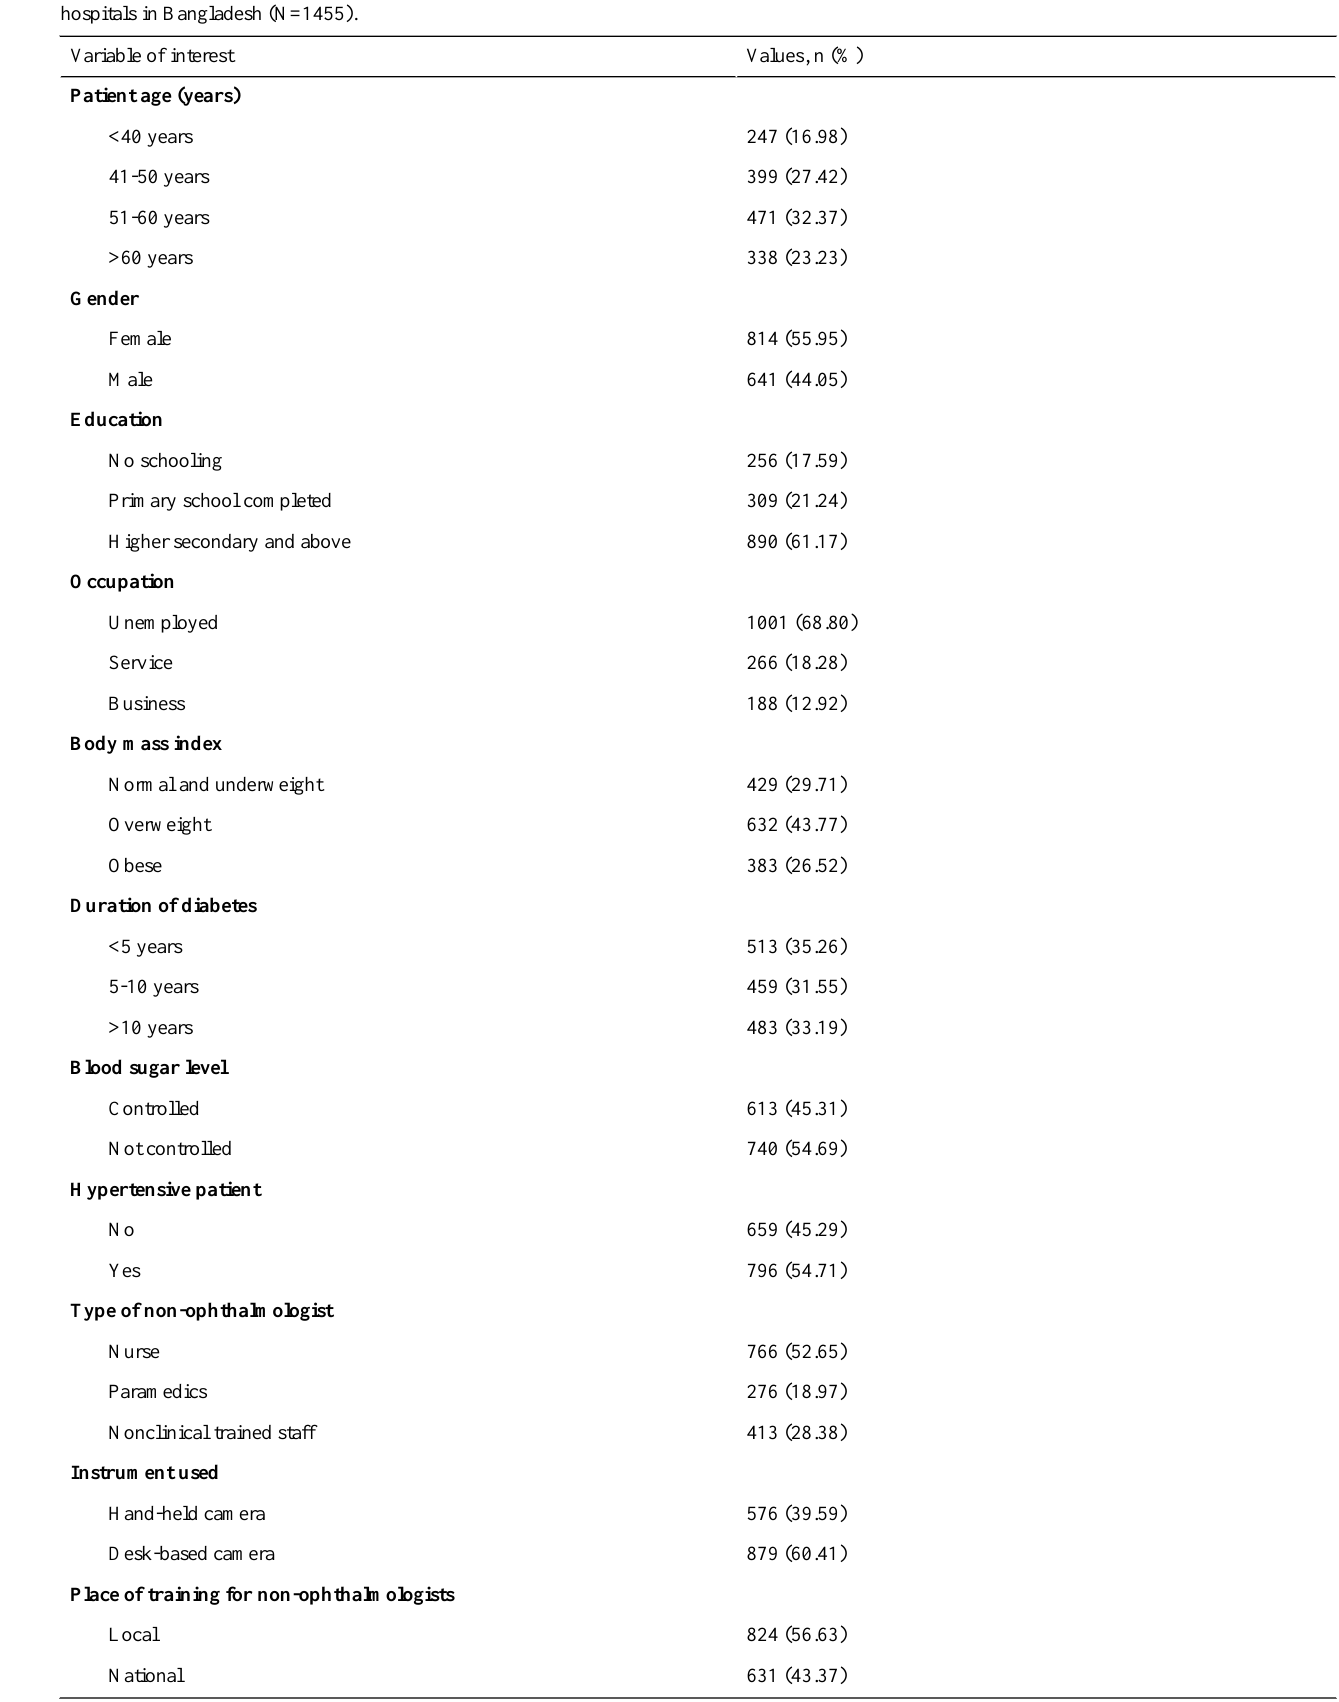
Table 1. Characteristics of the study participants who attended diabetic retinopathy screening from July 2017 to June 2018 in 6 selected peripheral hospitals in Bangladesh